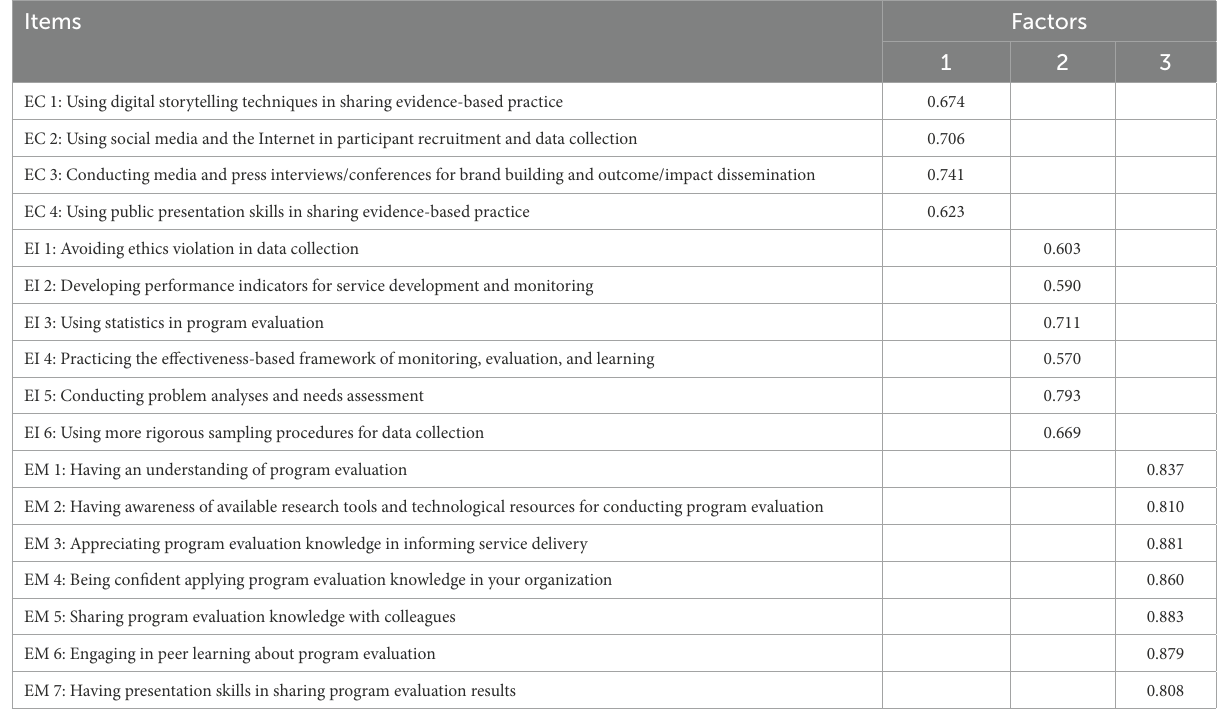
TABLE 2 Rotated factor loadings matrix from EFA ( n =